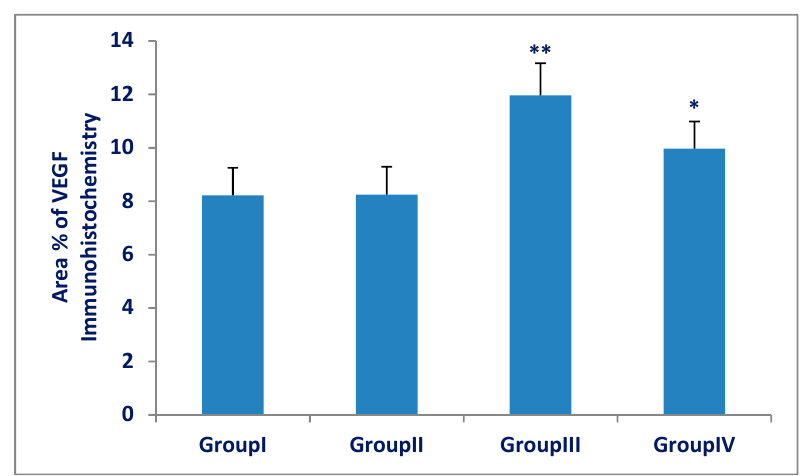
Figure 9. Area percentage of TNF- α of spleen in group (III) (Olanzapine-treated group) was significantly increased compared to group (I) (control group). A significant decrease in group (IV) (Olanzapine and vitamin C) as compared to group (III). The differences in area percentage of TNF- α between group (I) and group (II) were not significant ( p > 0.05). Results are expressed as mean ± SD and the level of significance was set for p -values less than 0.05. **: significant increase, group (III) versus group (I) ( p < 0.001). *: significant decrease, group (IV) versus group (III) ( p < 0.001).